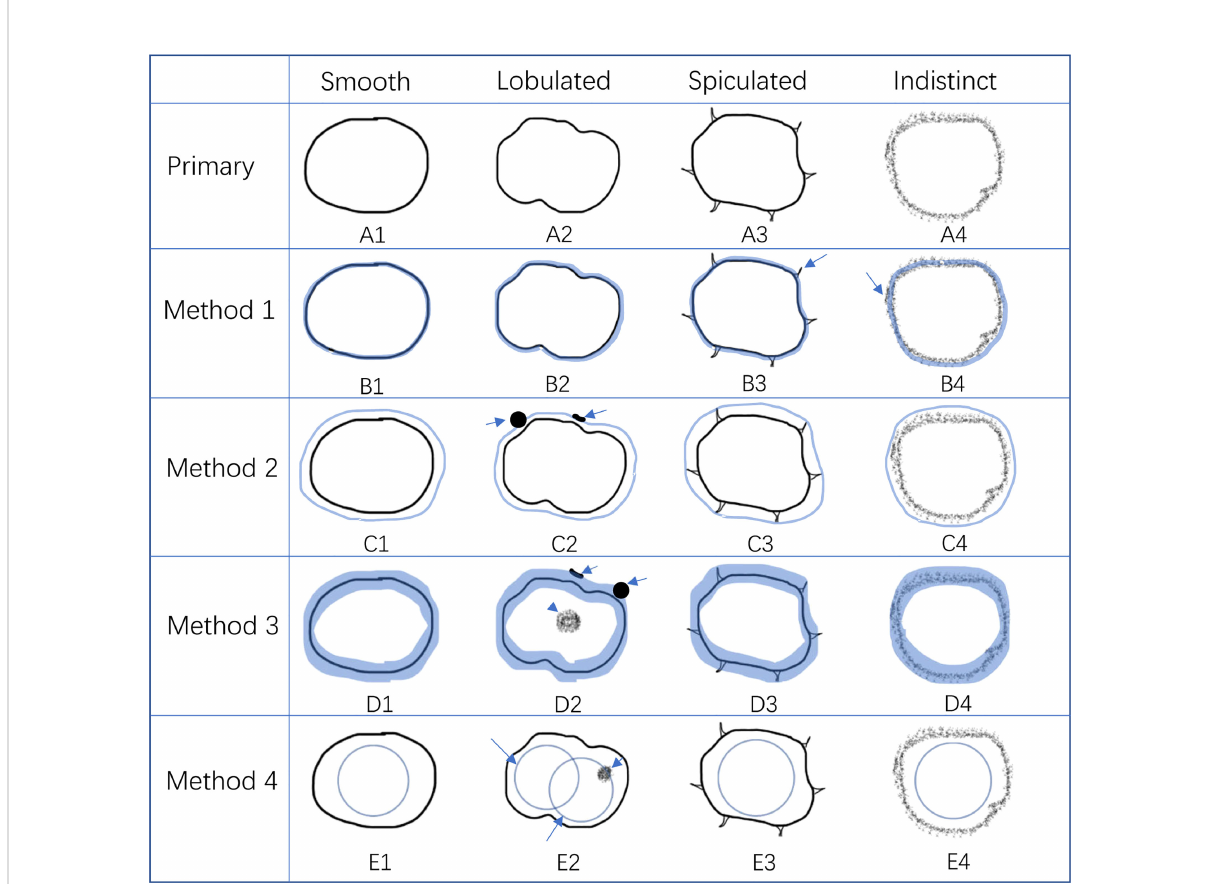
FIGURE 8 The advantage and disadvantage of four kinds of ROI segmentation methods. (A1 – 4) represent the characteristics of different borders of LNs, including smooth, lobulated, spiculated, and indistinct, according to Kim et al. (23). (B1 – 4) represent method 1 of ROI segmentation. It had good performance in smooth and lobulated border (B1, 2) but the burr of the spiculated border and part of the indistinct edge of the indistinct border were out of the ROI ( B3 , 4 , long arrow). (C1 – 4) represent method 2 of ROI segmentation. Although it covers